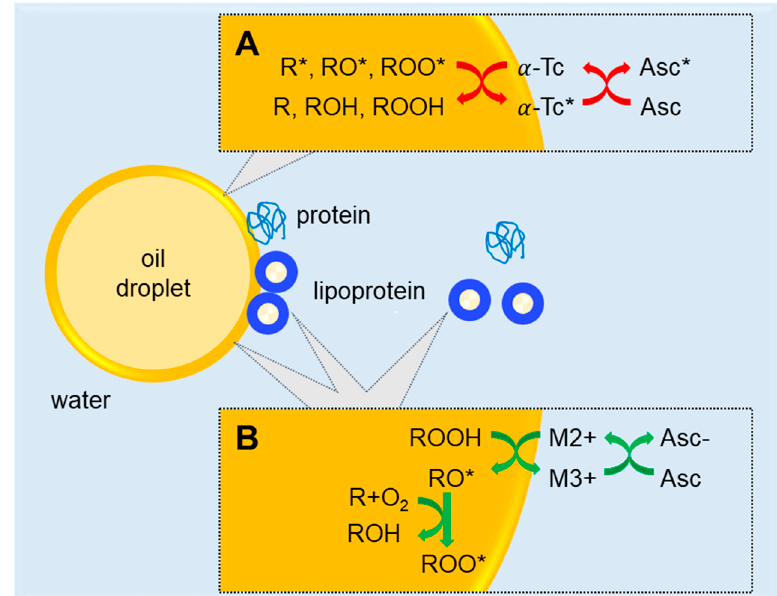
Figure 4. Overview of the mechanisms of lipid and protein oxidation present in oil-in-water emulsions. Oil droplets are shown in yellow; lipoprotein particles are presented with a yellow lipid core and a blue protein shell. For simplicity, these particles are not shown in their aggregated form in granules. Anti / pro-oxidant mechanisms are depicted at the interfacial droplet layer and at the lipoprotein surface. Anti- and pro-oxidant mechanisms are respectively indicated in red and green. ( A ) Ascorbic acid acts as an antioxidant for lipids by converting tocopherol radicals to tocopherol. ( B ) Pro-oxidant behavior of ascorbic acid on lipids and proteins, including lipoproteins, at the interface and the water phase. Mechanisms involve metal chelation as well as free radical scavenging. ROOH: lipid hydroperoxide; R: unsaturated lipids; R*: alkyl radical; RO*: alkoxyl radical; ROO*: peroxyl radical; ROH: hydroxy lipids; Asc: ascorbic acid; Asc − : dehydroascorbic acid; Asc*: ascorbyl radical; Tc: